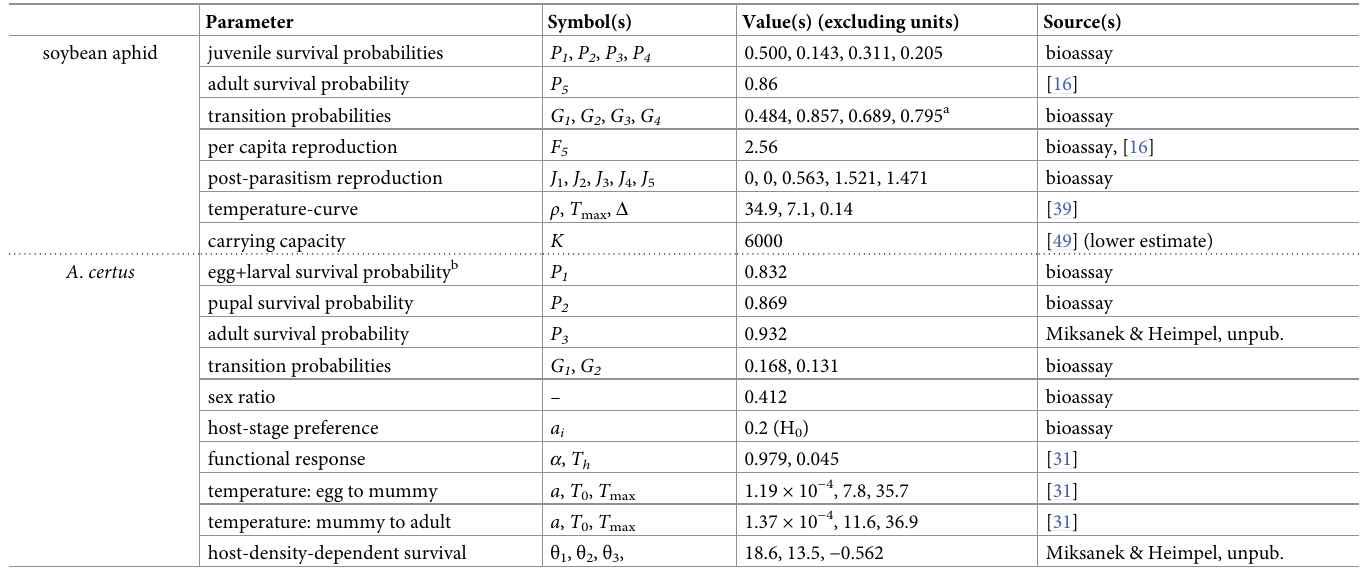
Table 2. Values and sources of parameters used in the matrix model.